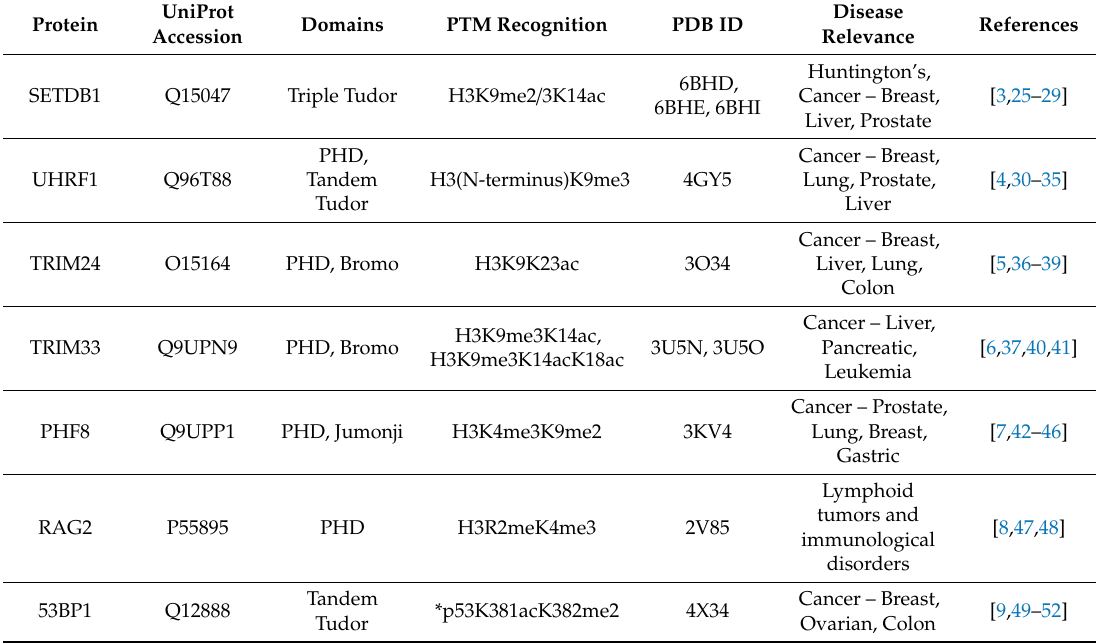
Table 1. Examples of proteins with multivalent post-translational modification (PTM) recognition including a methyl-lysine (Kme)